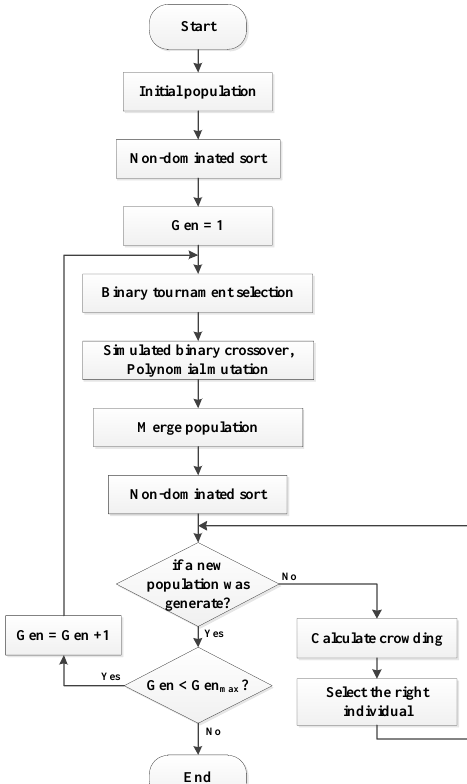
Figure 16. The optimization process of the non-dominated sorted genetic algorithm-II (NSGA-II)